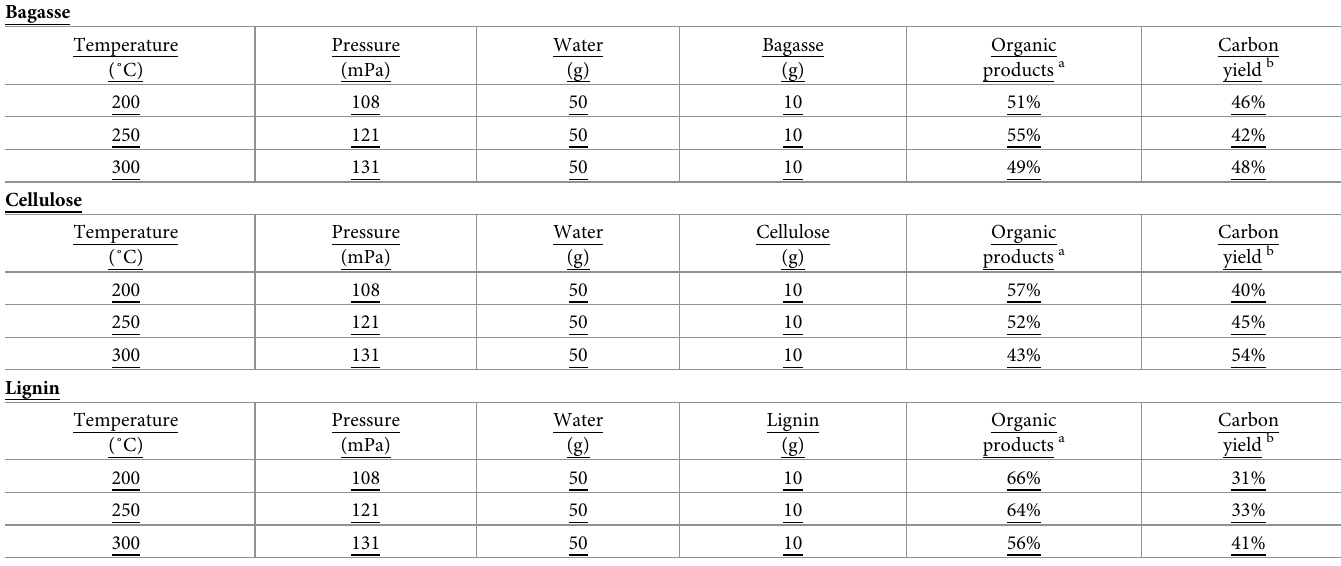
a The yield of organic products are estimated by subtracting the carbon yield from the total mass of biomass. b There is a ~3% mass lose because of the escape of volatile organic products from water